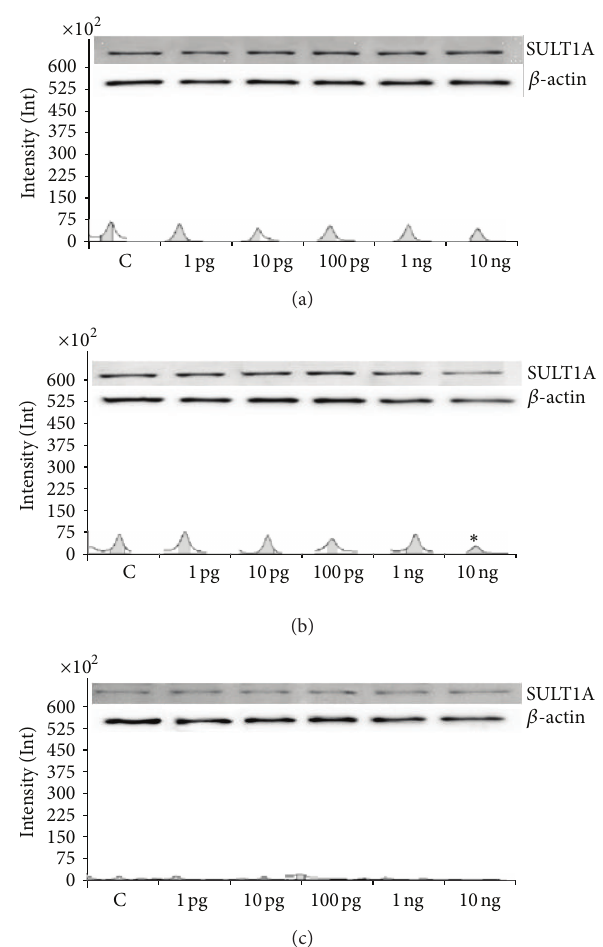
Figure 6: Protein expression (immunoblot) of SULT1A after 1 (a), 6 (b), and 48 (b) hours of incubation with Halowax 1051. The amount of protein in each sample was checked using an anti- 𝛽 - actin antibody. All means marked with ( ∗ 𝑃 < 0.05 ) are significantly different from the